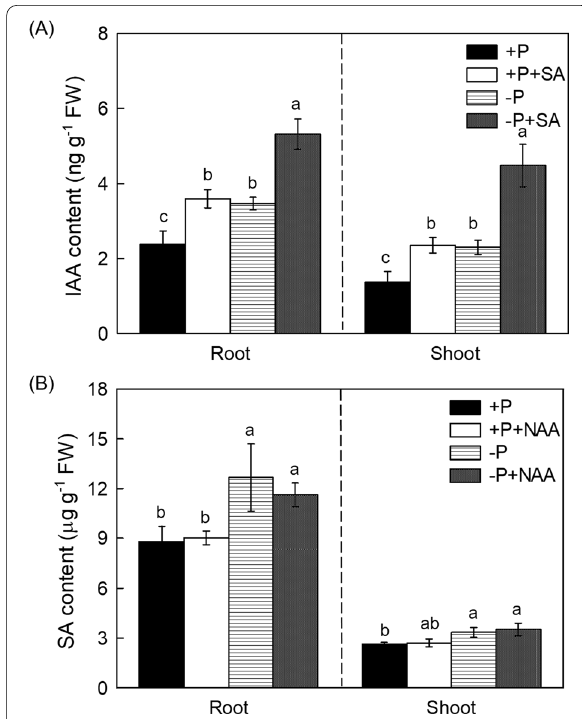
Fig. 8 SA increases the root and shoot IAA content in response to P starvation in rice. IAA ( A ) and SA content ( B ) in root and shoot under different conditions were measured. Data are means different letters represent significant differences by Duncan’s multiple range test at the P <